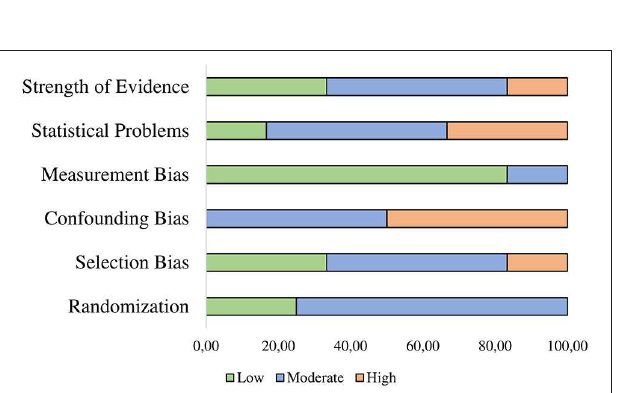
FIGURE 5 | Funnel plot for the meta-analysis of the effect of self-management smartphone-based apps on depressive symptoms.